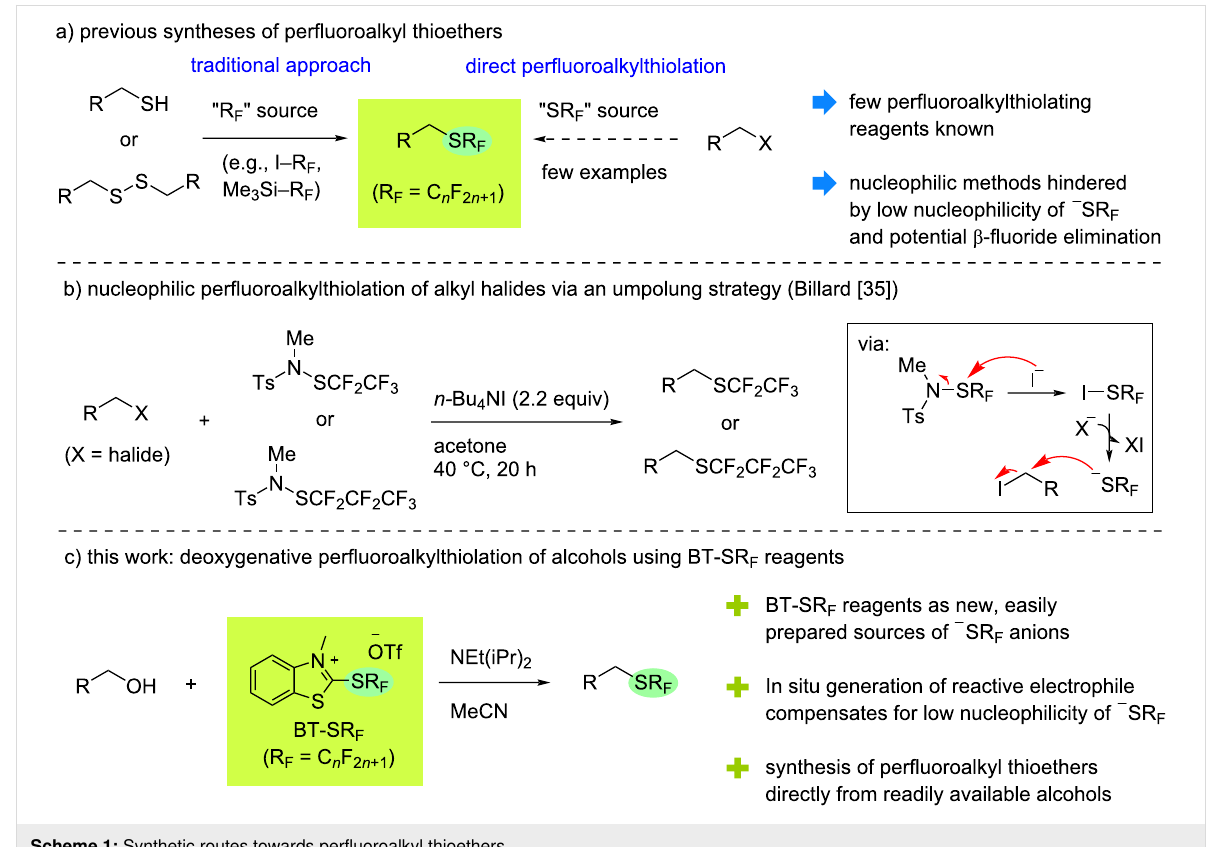
Scheme 1: Synthetic routes towards perfluoroalkyl